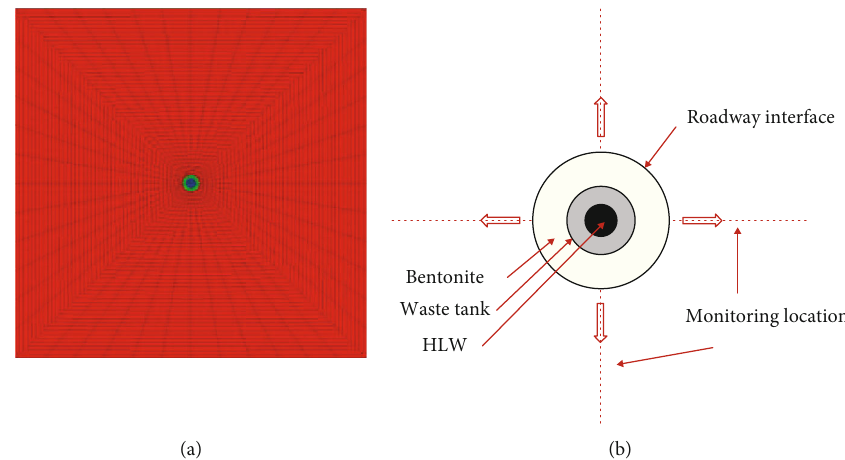
Figure 5: Disposal depot numerical model and monitoring point location schematic diagram: (a) Numerical model of tunnel with nuclear waste tank; (b) Schematic diagram of numerical model monitoring point layout. Table 1: Calculation parameters of Tamusu clay